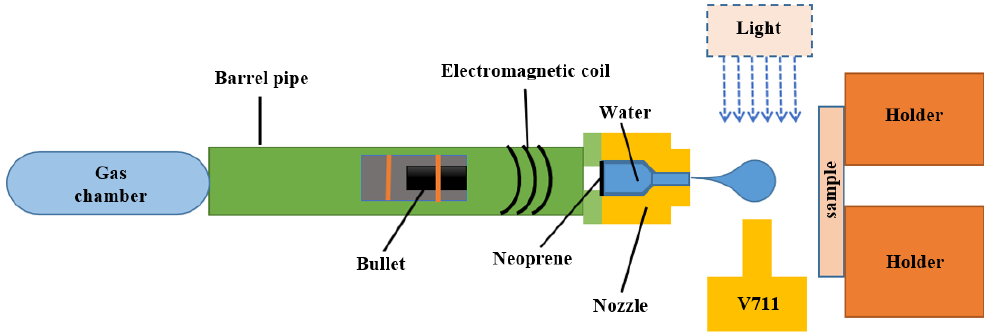
Figure 1. Platform for single jet impact